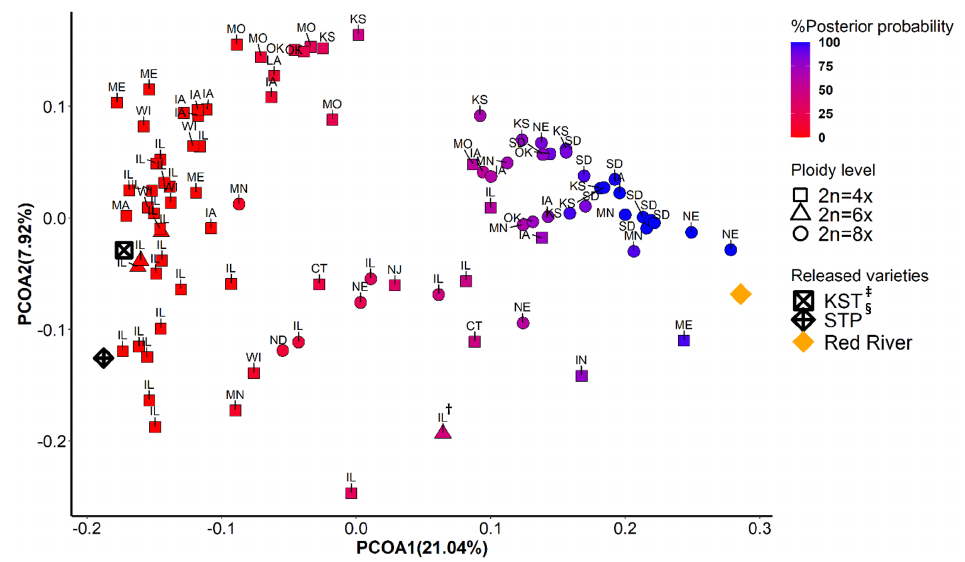
Figure 2. Principal coordinate analysis using 9315 SNPs data. The scores from the first (PCOA1) and the second (PCOA2) were plotted on x - and y -axis, respectively. The populations were colored in a gradient scale based on the posterior of probability assigned to two genetic groups inferred from fastStructure and DAPC . Shapes correspond to three levels of ploidy. † : A hexaploid popu- lation collected from Illinois; ‡ : KST = Kingston germplasm, Big Flats plant material center, NY;